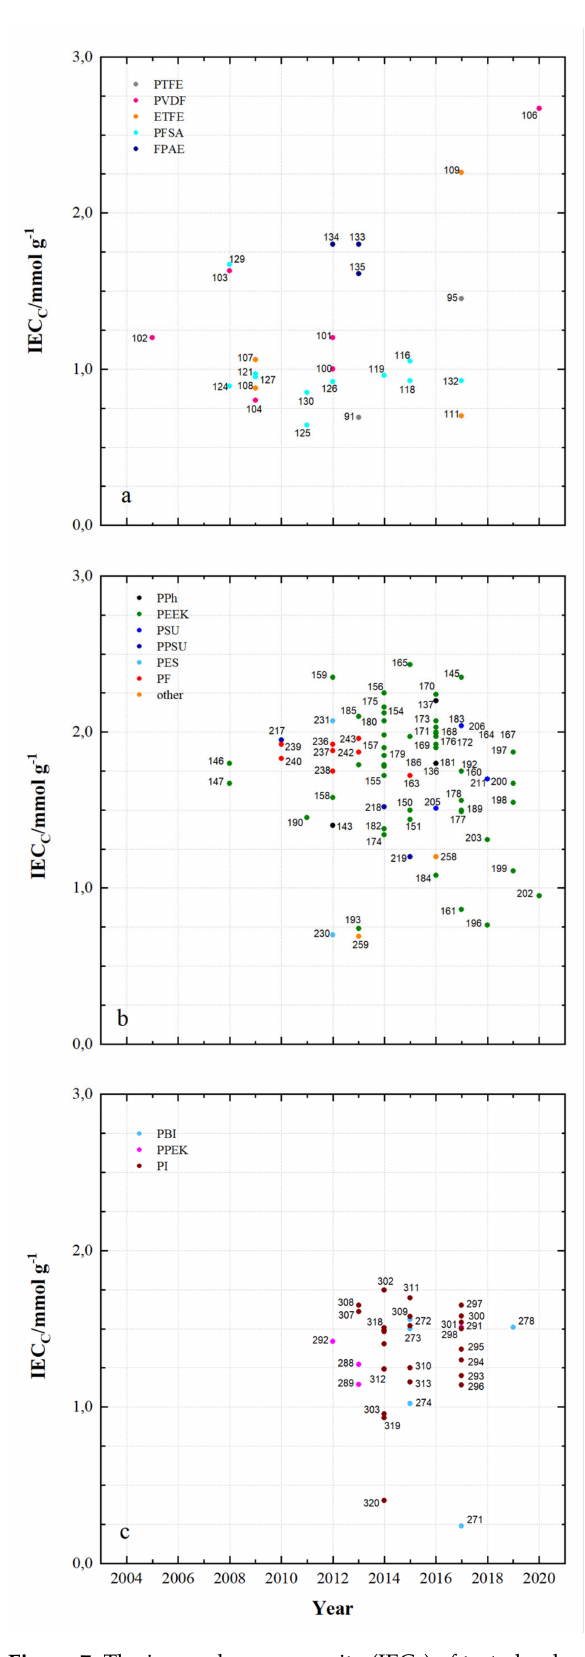
Figure 7. The ion-exchange capacity (IEC c ) of tested polymer membranes in recent years: ( a ) fluoro- carbons, ( b ) hydro-carbons and ( c ) N